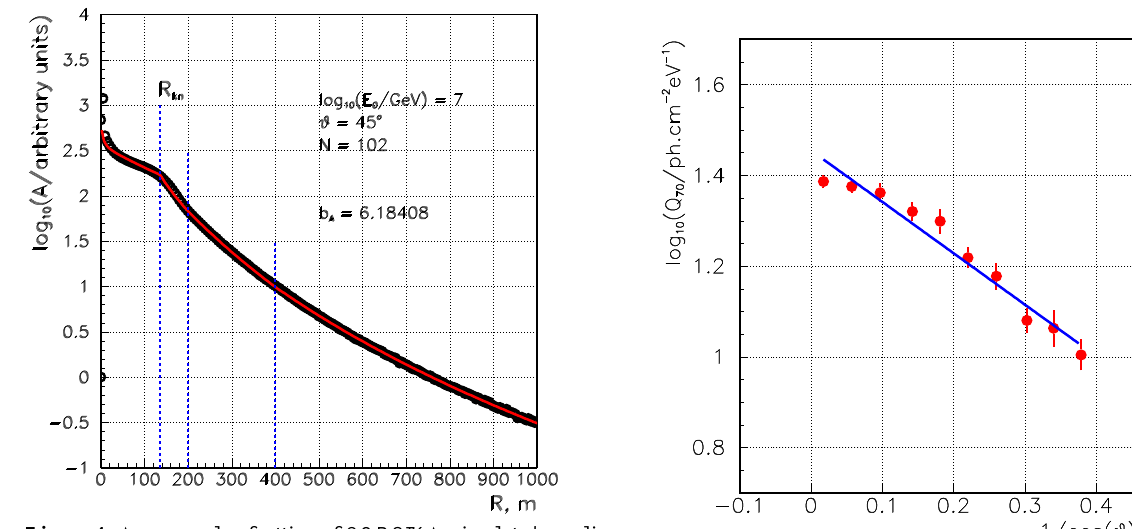
Figure 4. An example of fitting of CORSIKA simulated ampli- tude distance function with an expression from [2] with a single shape parameter steepness b A .